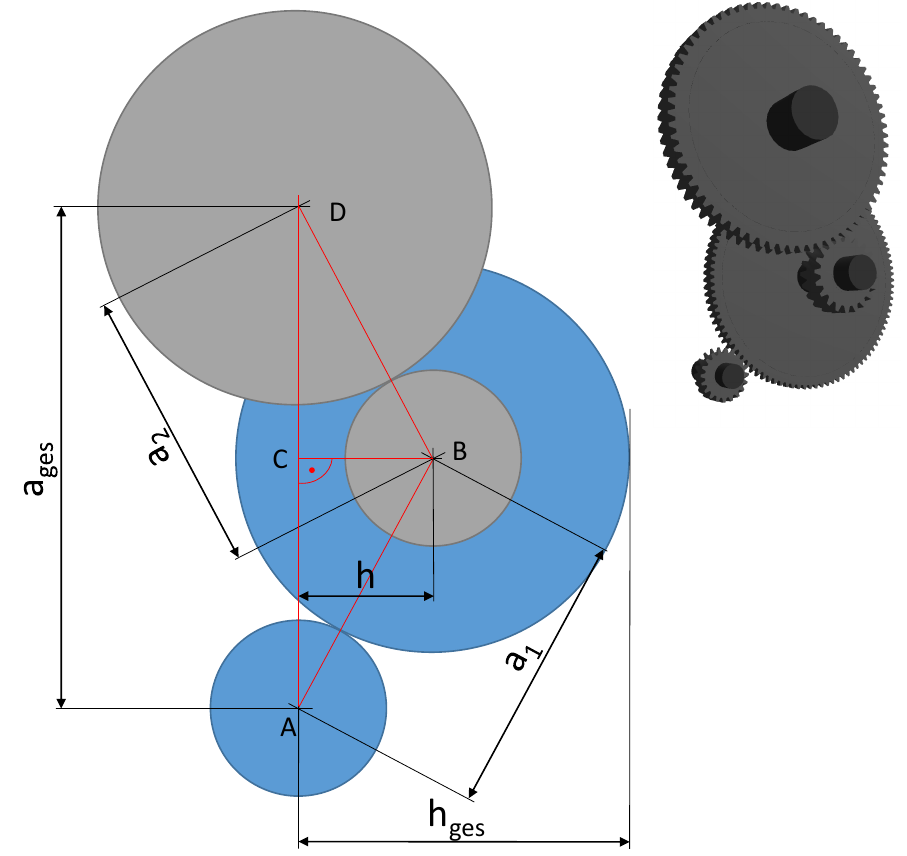
Figure 12. Geometrical parameters at a two-stage gear